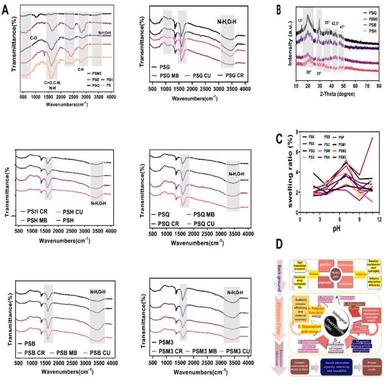
A, B, C, and D illustrate the graphical results of FTIR, XRD, swelling ratio measurements, and the experimental research flow, respectively.